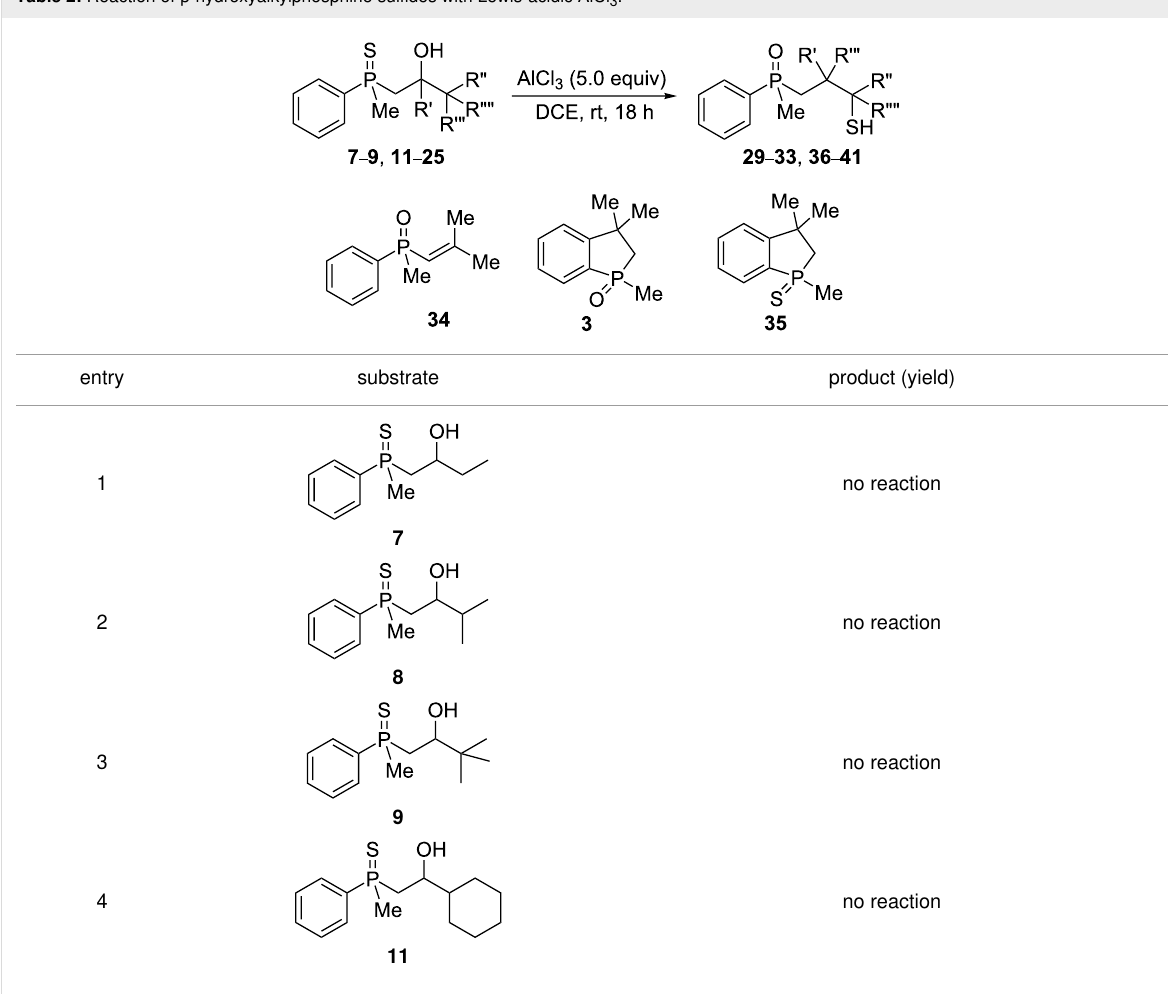
Table 2: Reaction of β -hydroxyalkylphosphine sulfides with Lewis-acidic AlCl 3